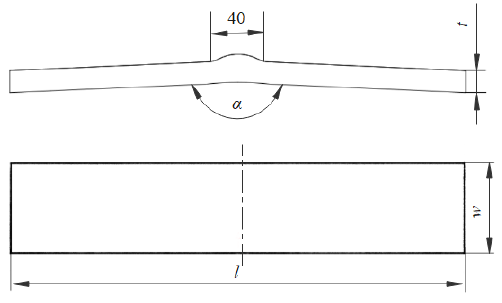
Figure 4. The geometry of the welding joint.